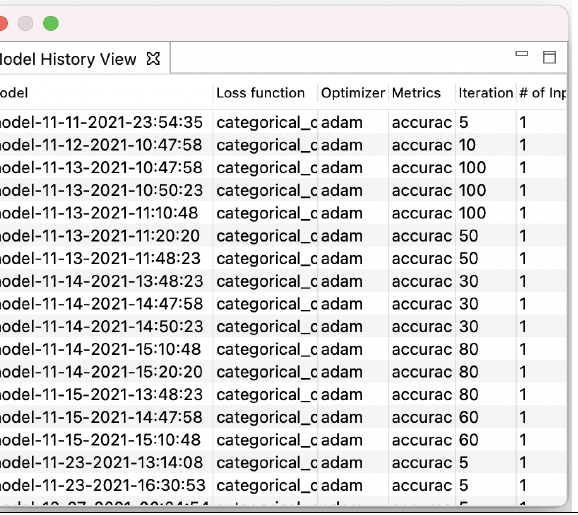
Figure 4. The tool screenshots of Model History View